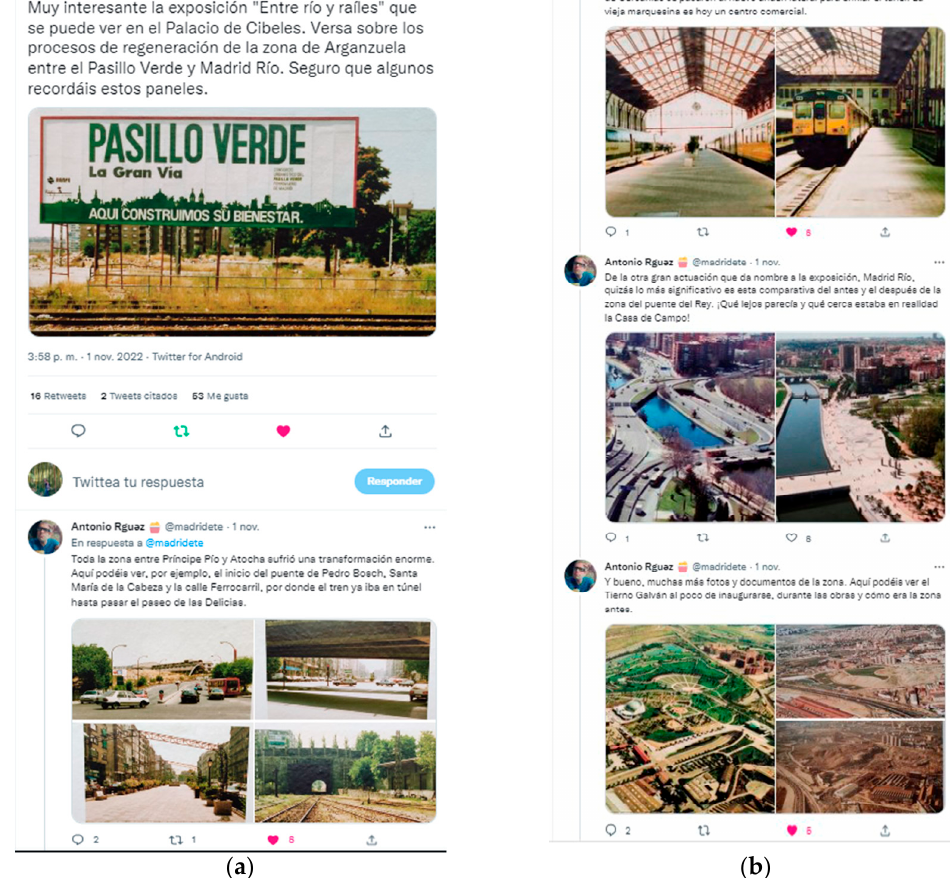
Figure 16. ( a , b ) Twitter thread from a citizen who made the story about the PVF his own and enriched it with his memories. ( a ) It reads: “The Exhibition Between River and Rails that can be seen in the Palacio de Cibeles is very interesting. It deals with the regeneration processes of the Arganzuela area between the Green corridor and Madrid R í o. Surely some of you remember these panels” ( . . . ) “The whole area underwent a huge transformation. Here you can see, for example, the beginning